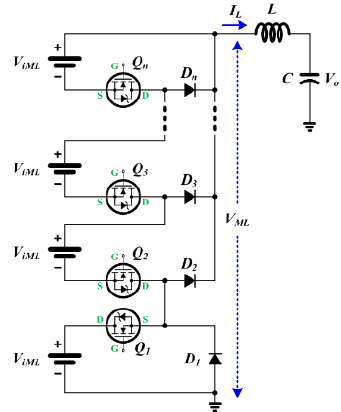
Figure 2. Topology of the existing diode series structure multilevel converter (DSS-MLC).